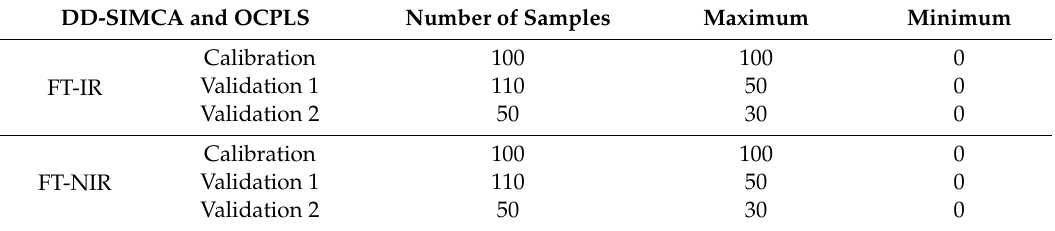
Table 1. Summary of sample information for the calibration and validation data set for data-driven soft independent modeling of class analogy (DD-SIMCA) and one-class partial least squares (OCPLS) analyses (excluding the number of samples, all units in %) based on the FT-IR- and FT-NIR-measured